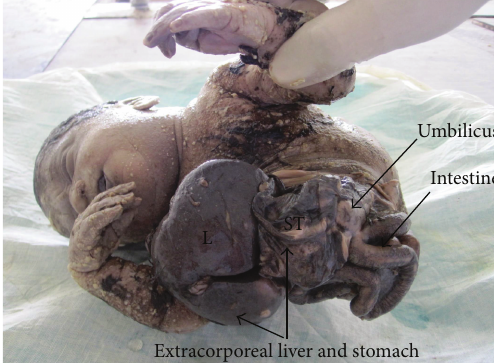
Figure 2: Showing abdominoschisis with evisceration of stomach, intestine, and extracorporeal liver.